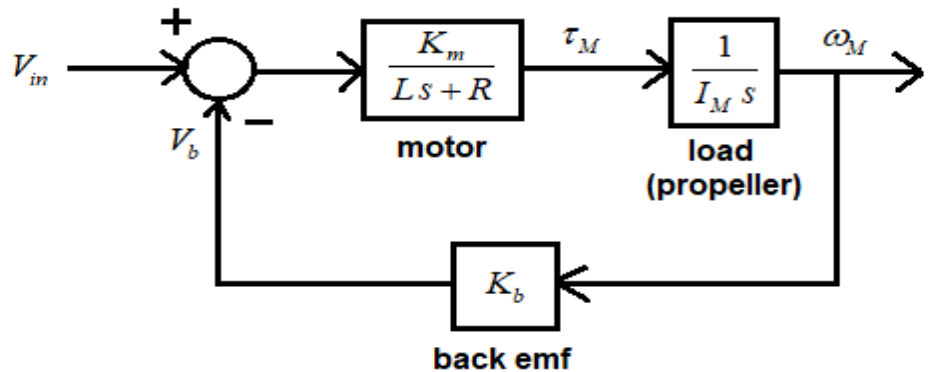
Figure 8. Block diagram of brushless, DC motor for a single phase with a load attached.